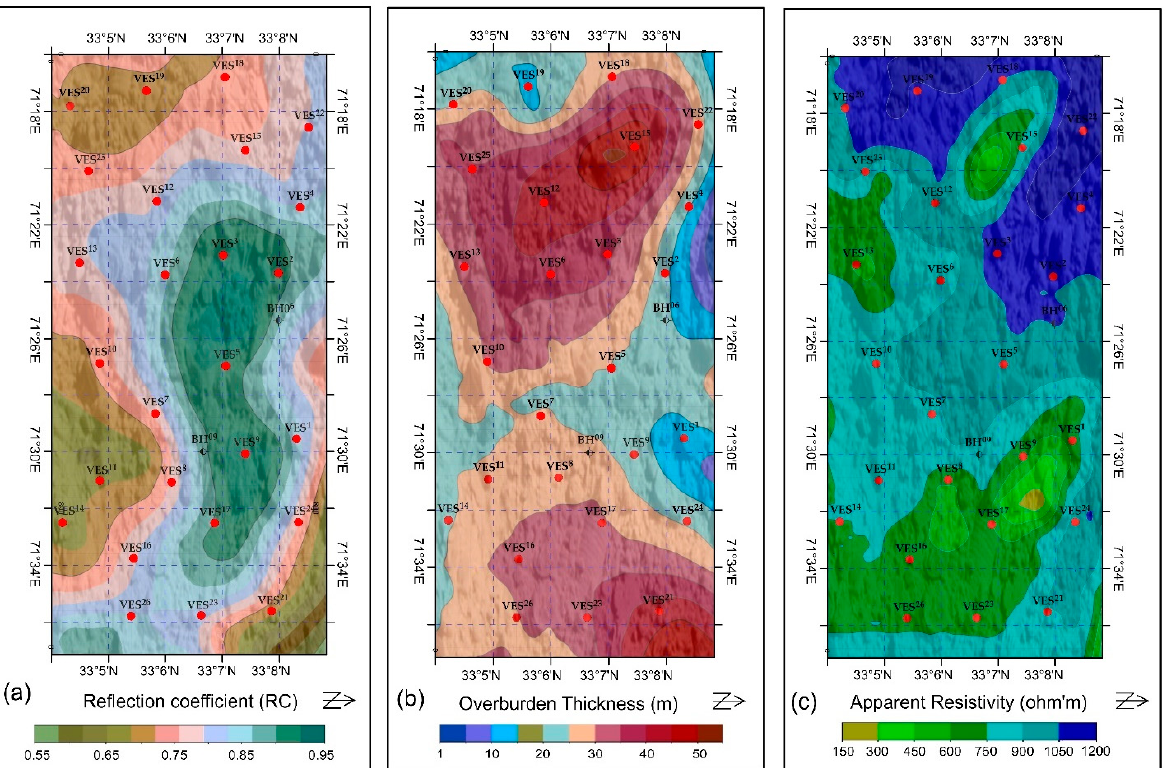
Figure 14. ( a ) Reflection coefficient map; ( b ) overburden thickness map; ( c ) apparent resistivity map based on the interpretation of VES data.